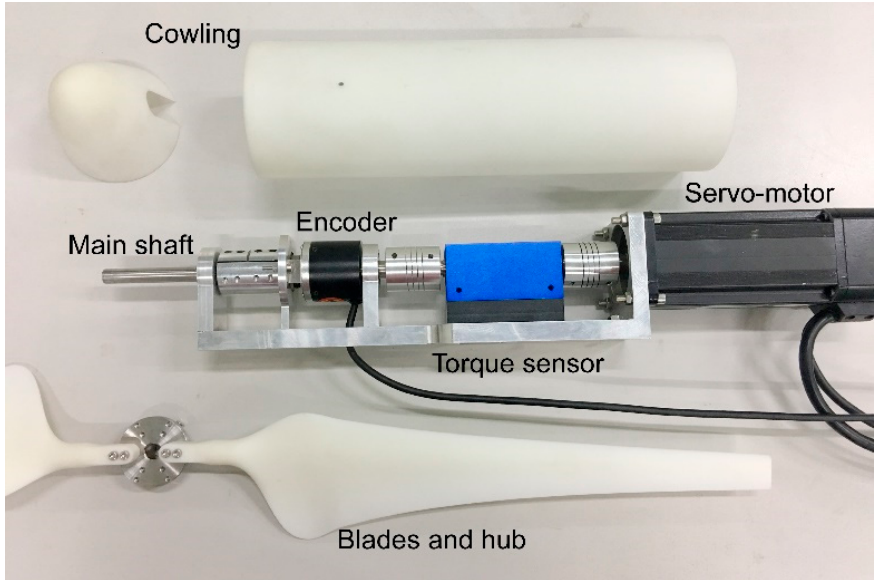
Figure 5. Wind turbine model and measurement equipment.